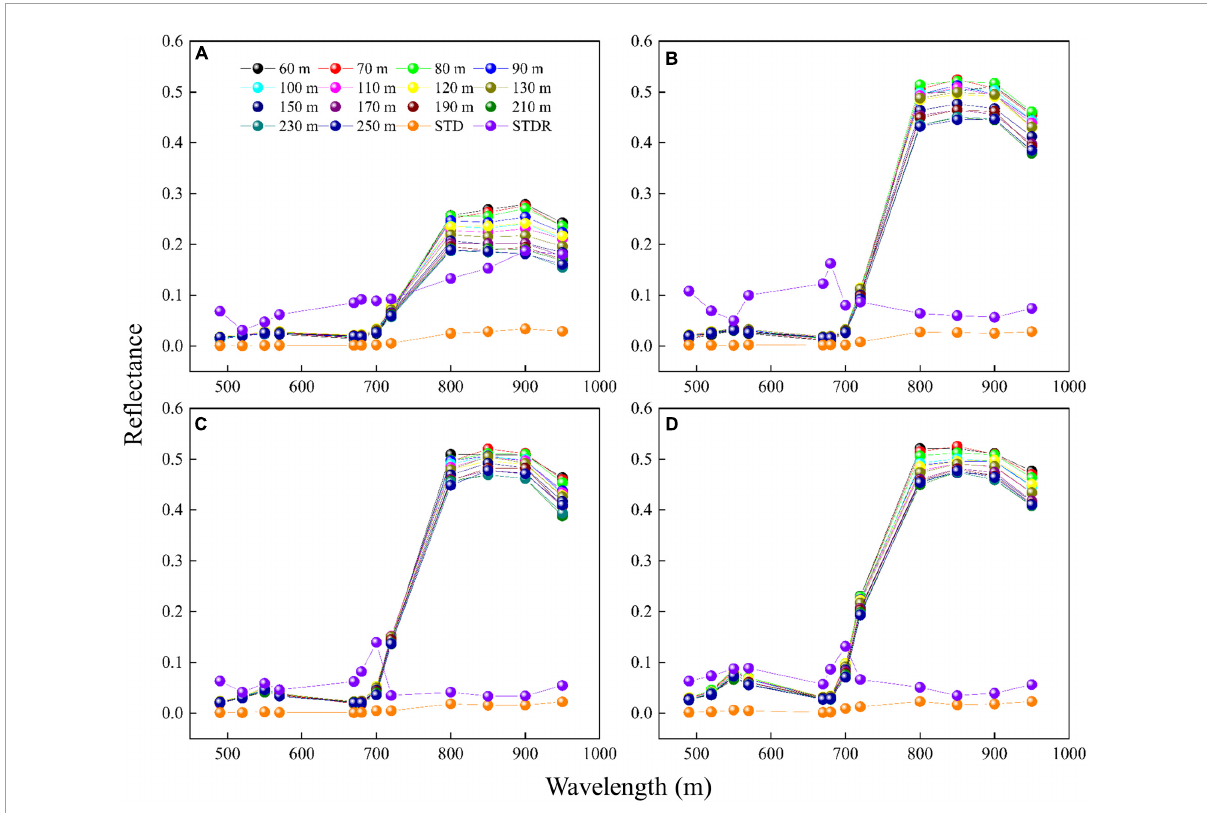
FIGURE7 Reflectance spectral curves of rice at different altitudes and stages (STD represents the standard deviation of spectral reflectance at all altitudes and STDR is the ratio of the STD to the reflectance at 250 m): (A) Tillering stage; (B) jointing stage; (C) heading stage; (D) milking